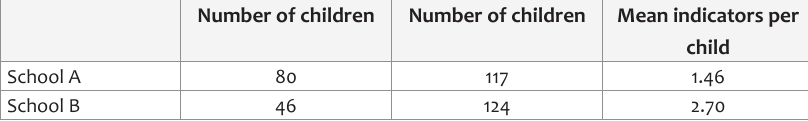
Table 1: Frequency of drawn indicators Number of children Number of children Mean indicators per